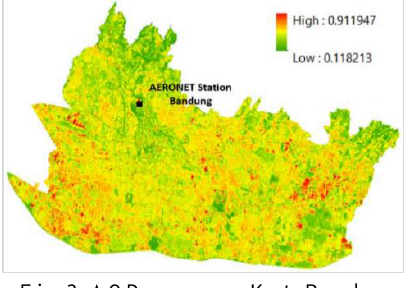
Fig. 3. AOD map over Kota Bandung